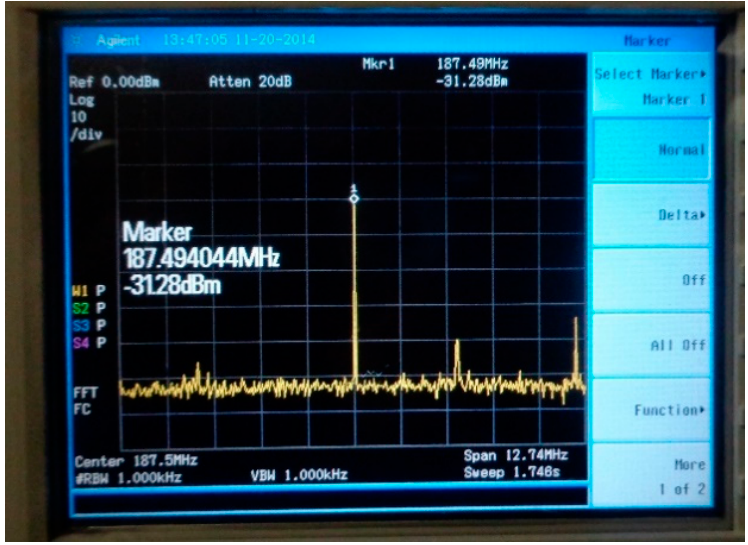
Figure 10. The measurement result for 187.5 MHz frequency for vertical plane.